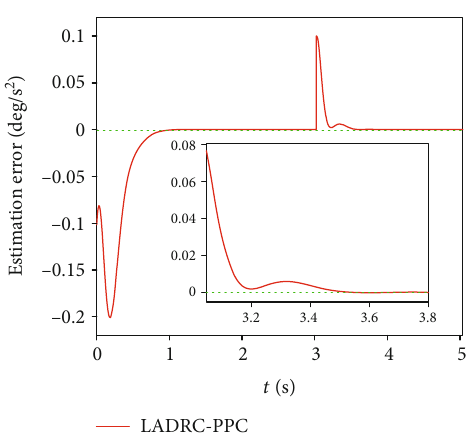
Figure 18: Estimation error of f with LADRC-PPC.